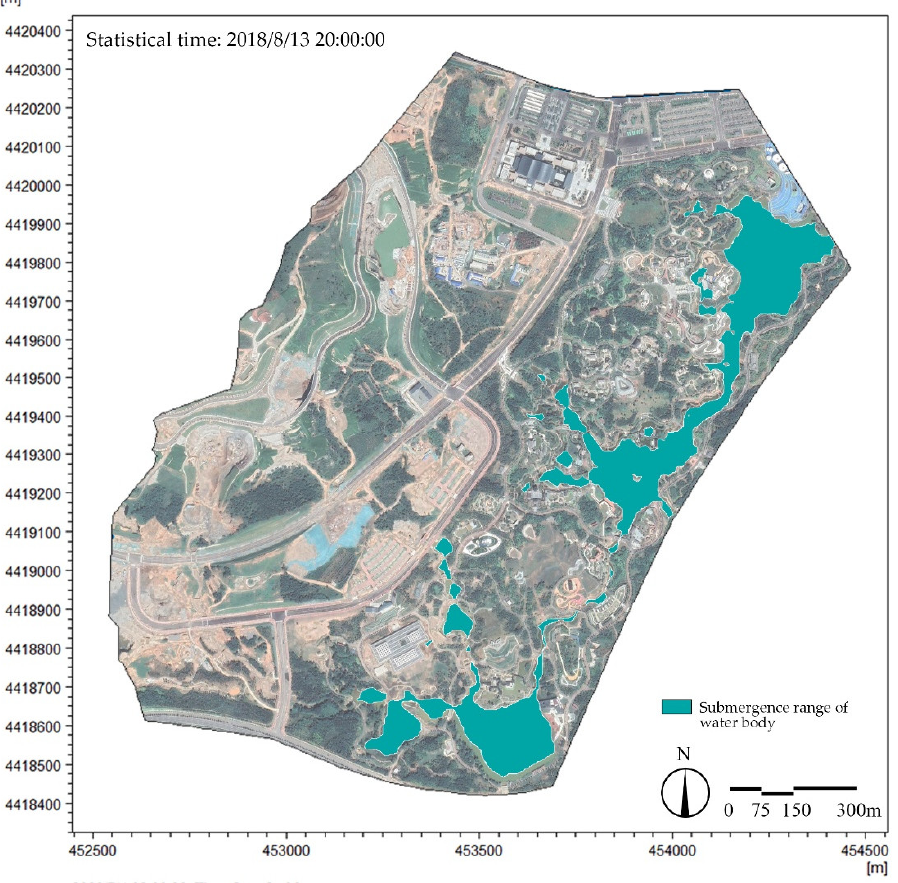
Figure 14. Distribution of submerged area of landscape water system in the study area. Note: The water system distribution map at other times is annexed.